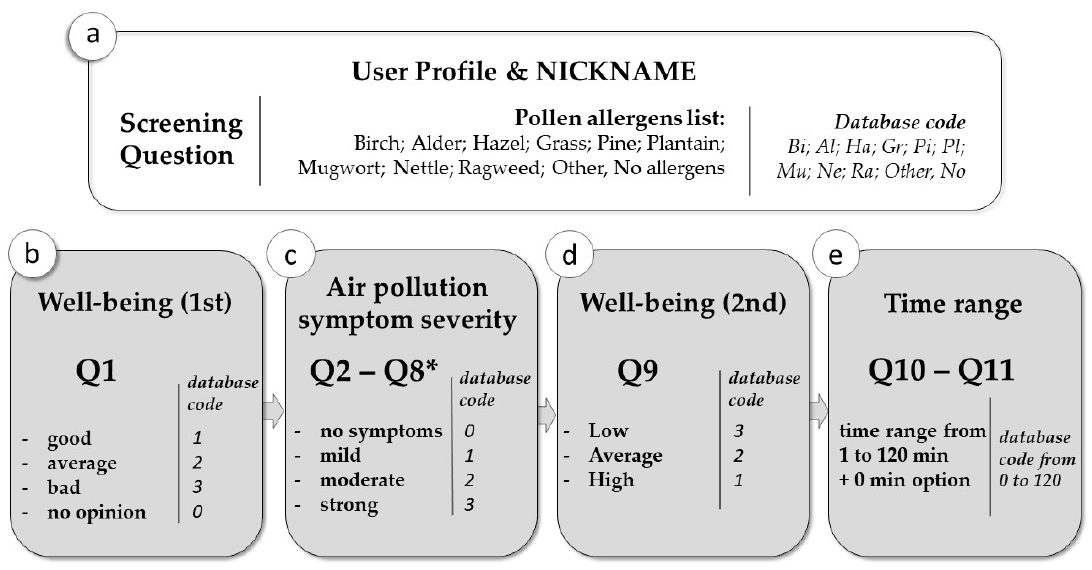
Figure 1. The flowchart of the air pollution symptom mapping (APSM) questionnaire: ( a ) the user-screening question about pollen allergy as well as an individual nickname and survey four-digit code assigned to the users’ profile, ( b ) the introducing question about subjective well-being (asked at the very beginning of the survey), ( c ) the set of seven close-ended questions about individual symptoms (question no 8 was answered, “Seldom,” “Quite often,” “Very often,” or “I do not rub eyes”), ( d ) closing questions about subjective well-being, and ( e ) time and geographical location recording.